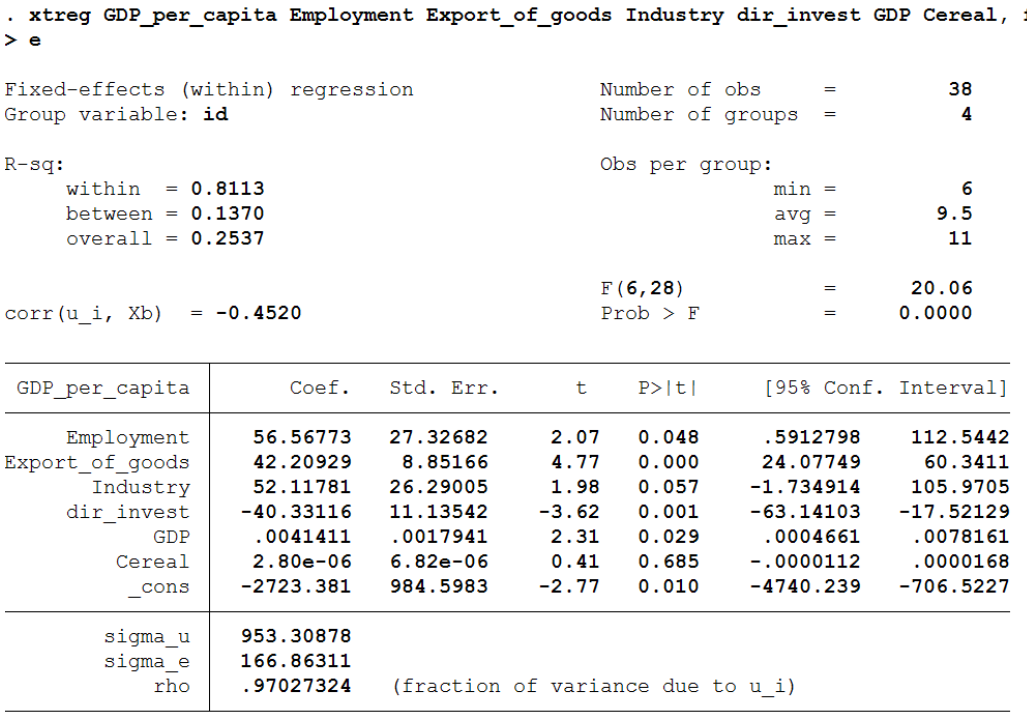
Figure 6. Results of assessing the impact of cereal production on the economic development level of the